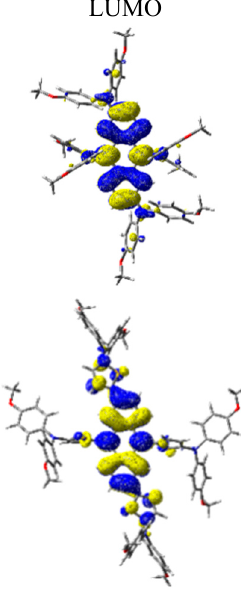
Figure 3. Frontier molecular orbitals for X1 and X2 .